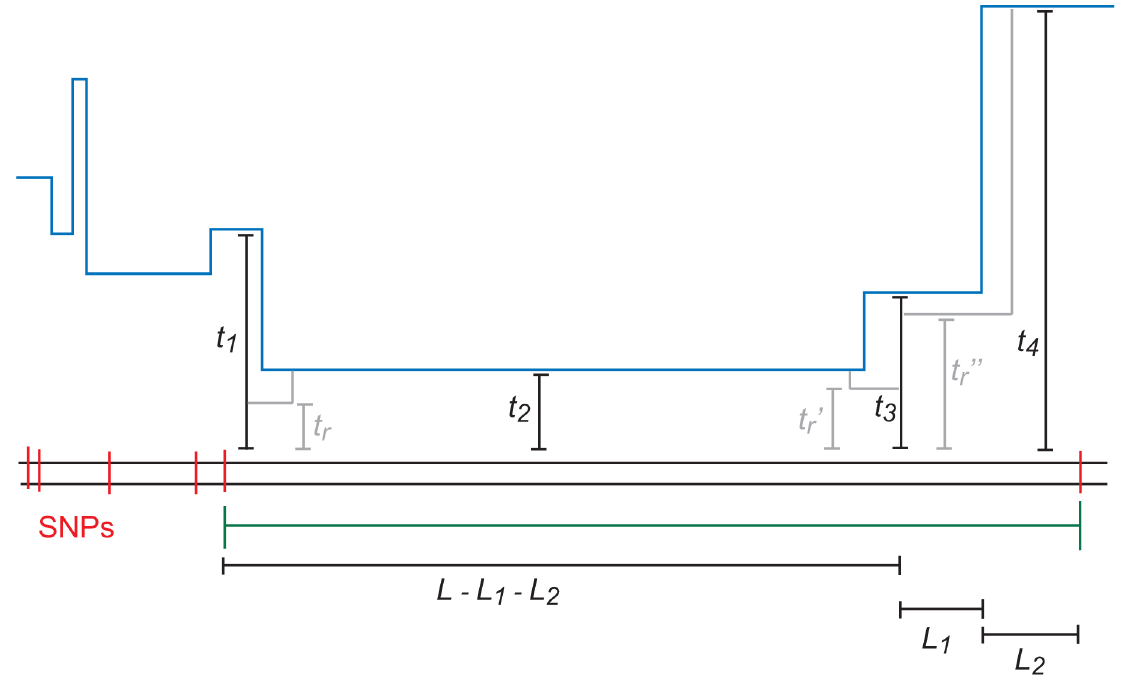
Figure 10. An L -base IBS tract with three recombination events in its history. A blue skyline profile represents the hidden coalescence history of this idealized IBS tract. In order to predict the frequency of these tracts in a sequence alignment, we must integrate over the coalesence times t 1 , t 2 , t 3 as well as the times t r v min( t 1 , t 2 ) , t r ’ v min( t 2 , t 3 ) , and t r ’’ v min( t 3 , t 4 ) when recombinations occurred.